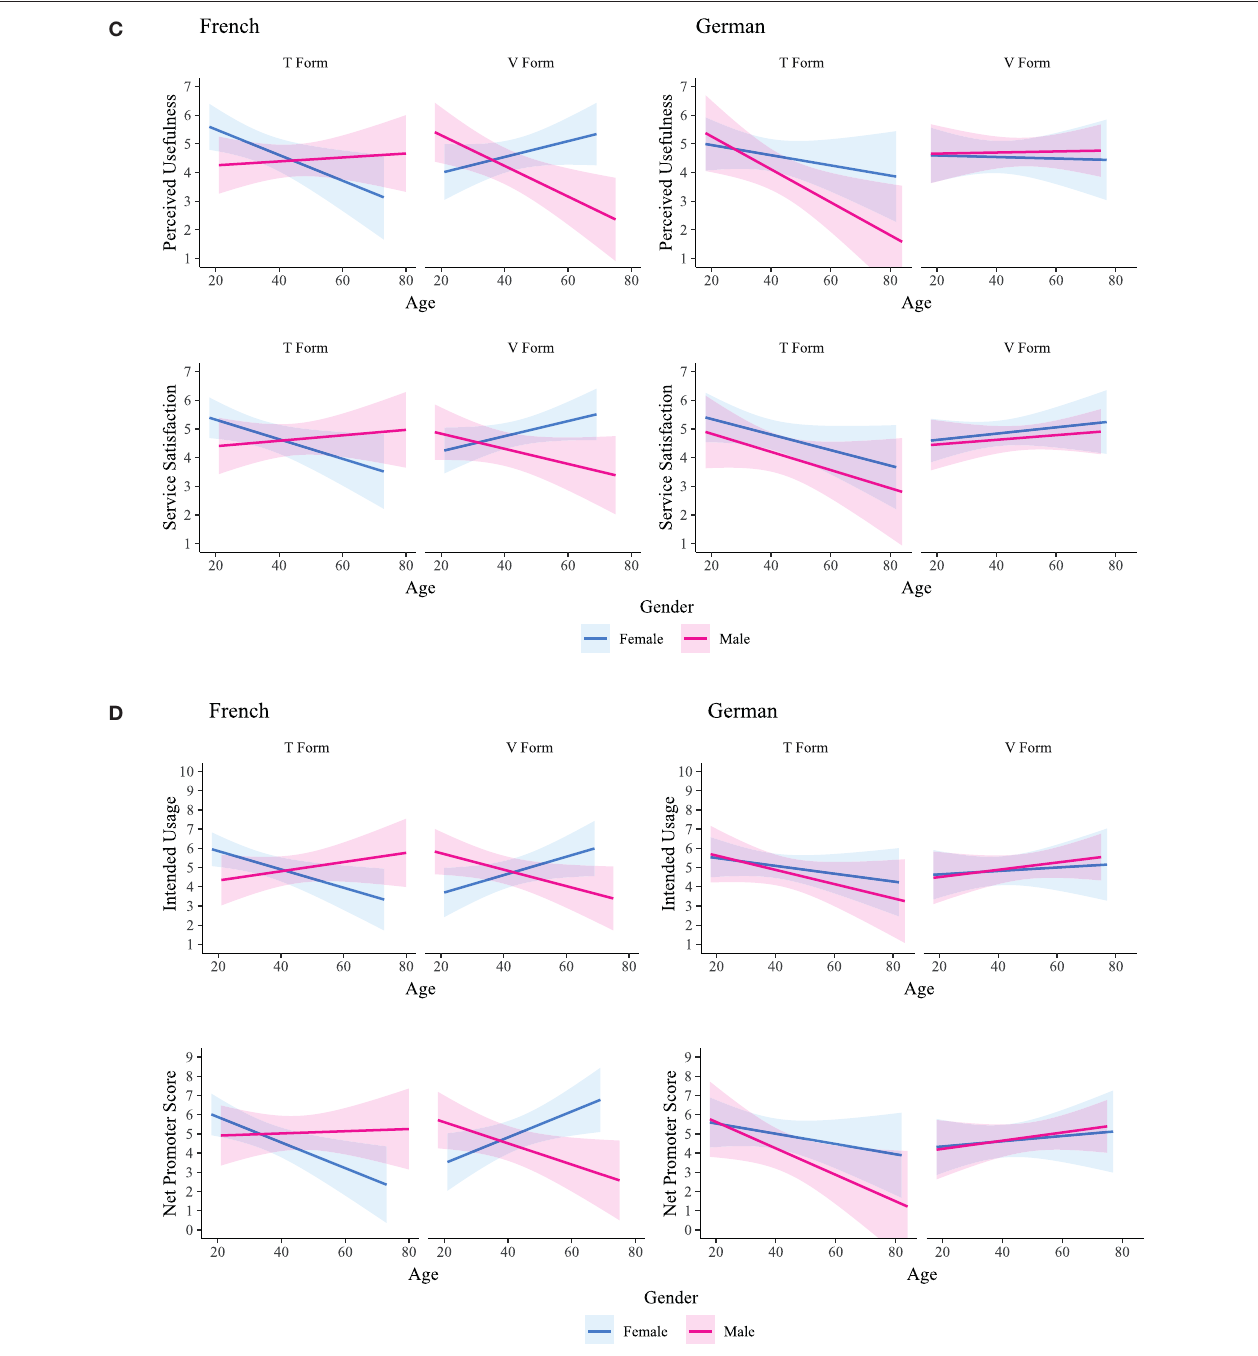
FIGURE 3 | (A) Sociability Outcomes. (B) CA-User Collaboration Outcomes. (C) Service Evaluation Outcomes. (D) Behavioral Intention Outcomes. Note: Four-way interaction graphs.